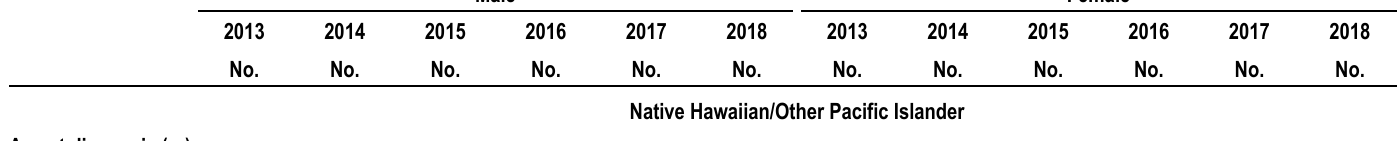
Table 9a. Diagnoses of HIV infection attributed to heterosexual contact, by selected characteristics, 2013–2018—United States (cont) Male